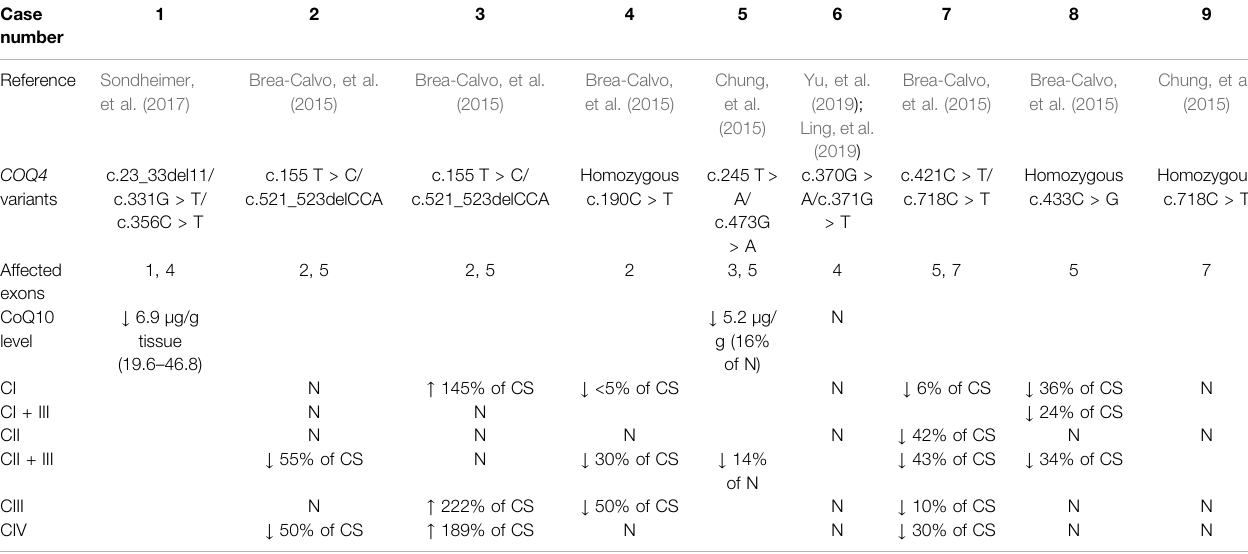
TABLE 5 | Biochemical analysis of muscle